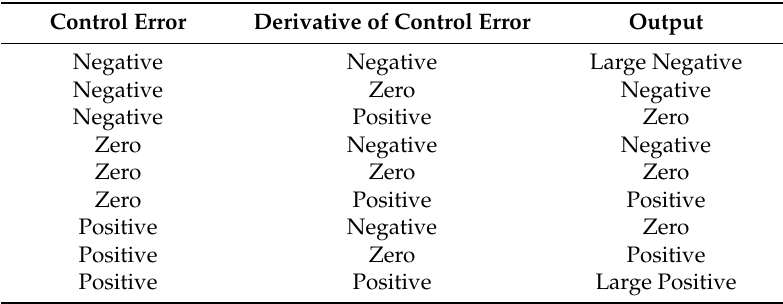
Table 2. The base rule of the fuzzy PD controller.